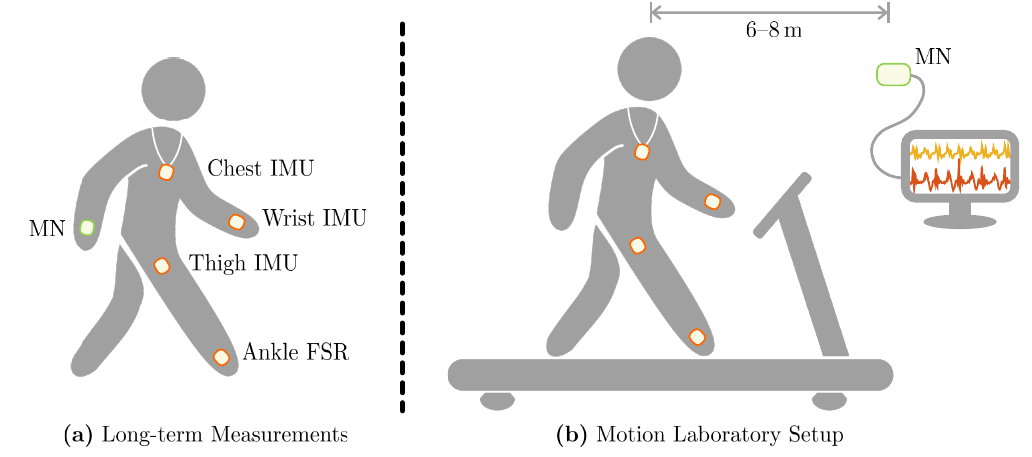
Figure 6. Application scenarios of the proposed sensor system realized in within this contribution. ( a ) The typical unobtrusive sensor setup for long-term measurements in everyday life. ( b ) Measurement setup during treadmill walking trials in the motion laboratory conducted for the validation